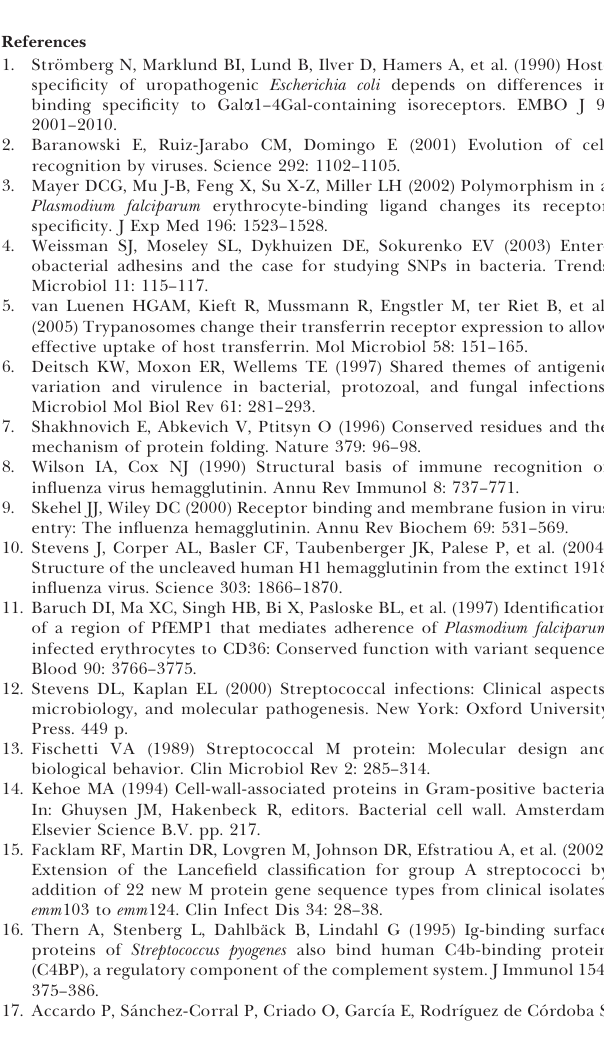
Figure S1. Sequence Logos Derived from HVRs in M